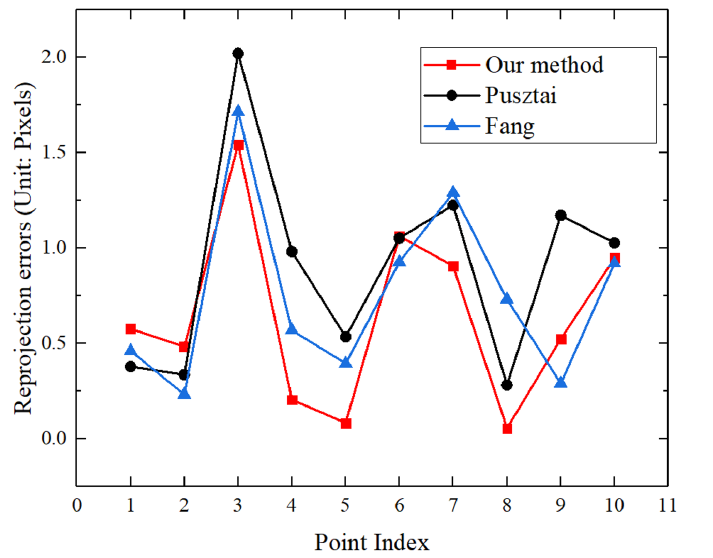
Figure 14. Reprojection error compared to other calibration